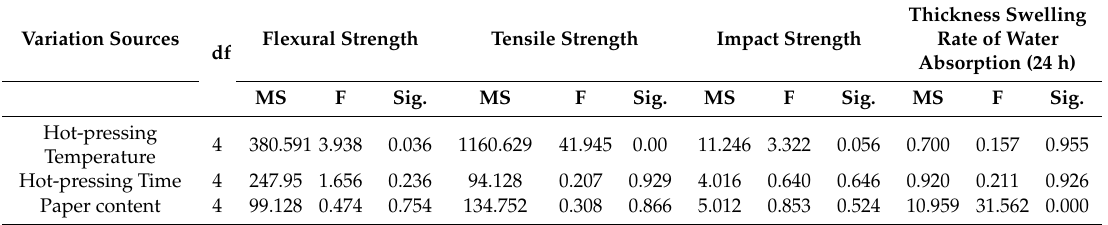
Table 2. Analysis of